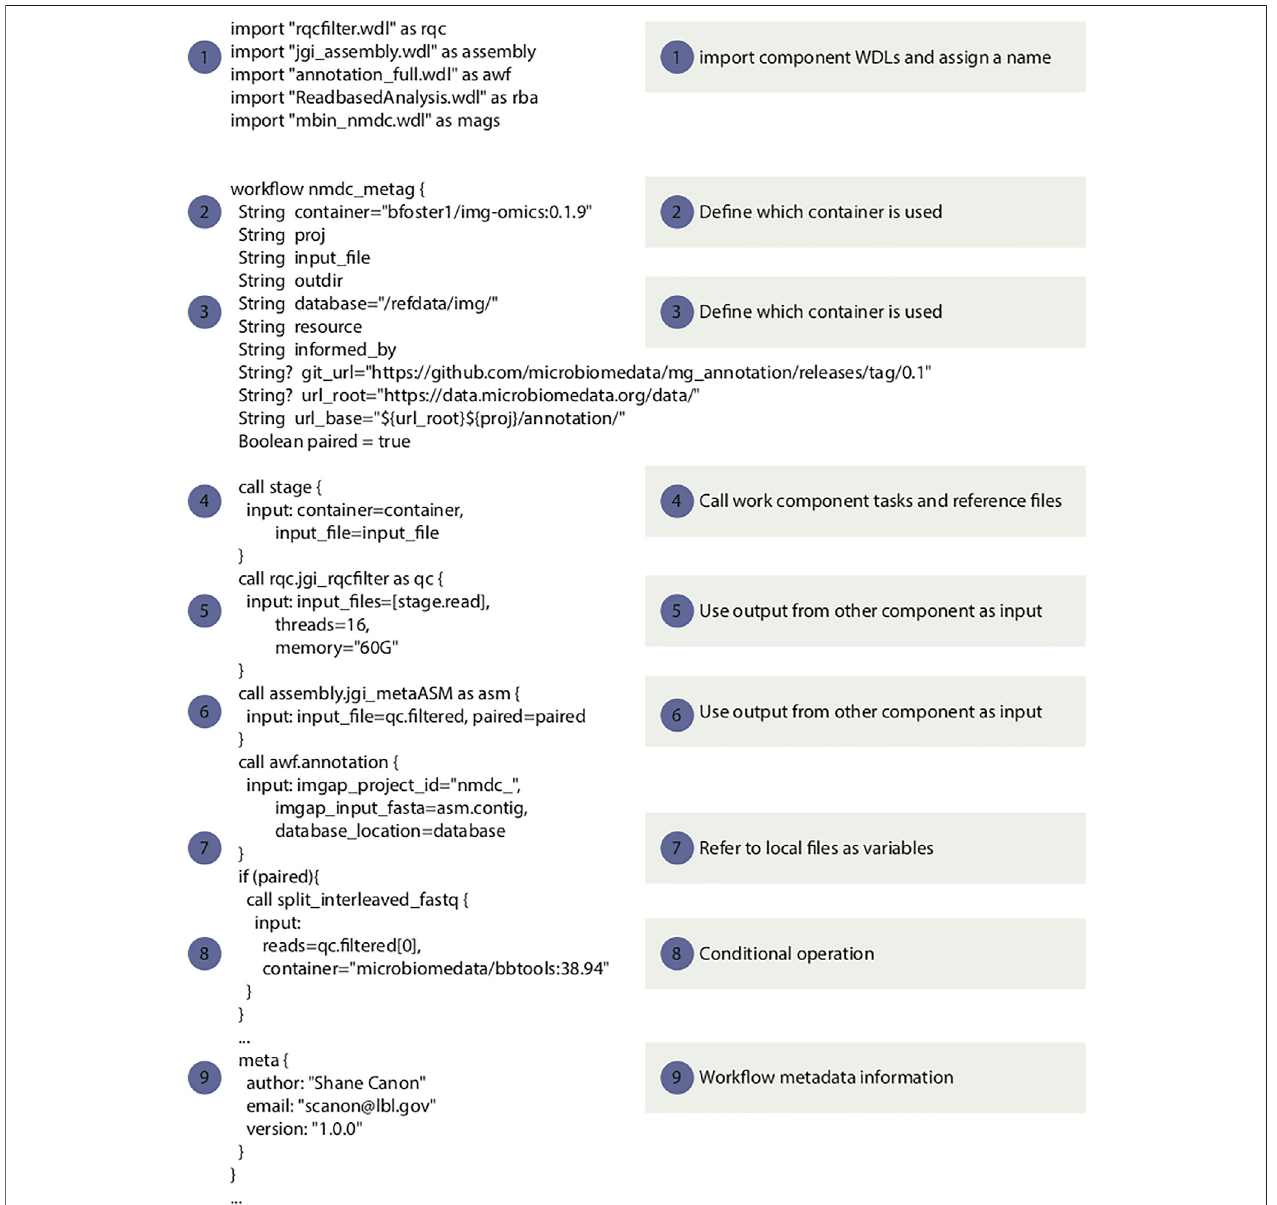
FIGURE 2 | Code snippets of the metagenomic data work fl ow to illustrate the WDL best practices listed in this paper 1: example use ofthe “ import ” function (best practicepoint1);2 – 4:examplesofusingcontainersinWDL(bestpracticepoints2-4and6);5 – 8:examplesofavoidsitespeci fi cimplementation(bestpracticepoint4);9: work fl ow metadata information (best practice point 8). The full work fl ow code is available from